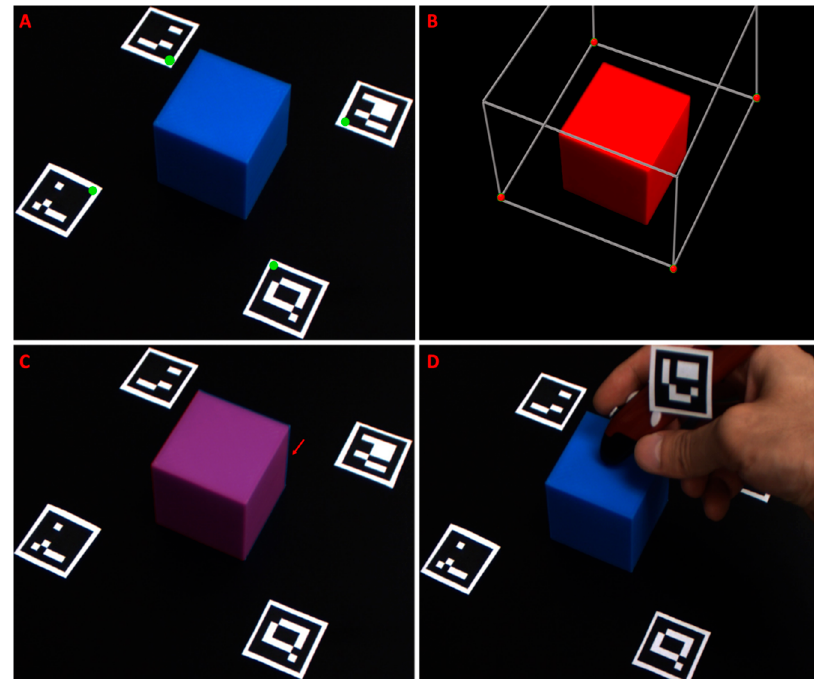
Figure 5. Registration accuracy assessment test for registering a 3D object with the system image sensors. ( A ) The 3D printed cube (blue) with fiducial markers placed for optimal alignment. The markers have been detected by the system, and green dots have been placed at the selected regis- tration corners; ( B ) The virtual cube (red) in 3D space. The cube is contained within the projection matrix (gray box) whose virtual fiducial points are indicated in red; ( C ) Co-registered image of the imaged blue cube with the virtual red cube (purple). The red arrow indicates a small registration misalignment where the blue of the real-world cube can be seen; ( D ) Using the stylus with affixed fifth Aruco marker to assign a fifth interior fiducial point.